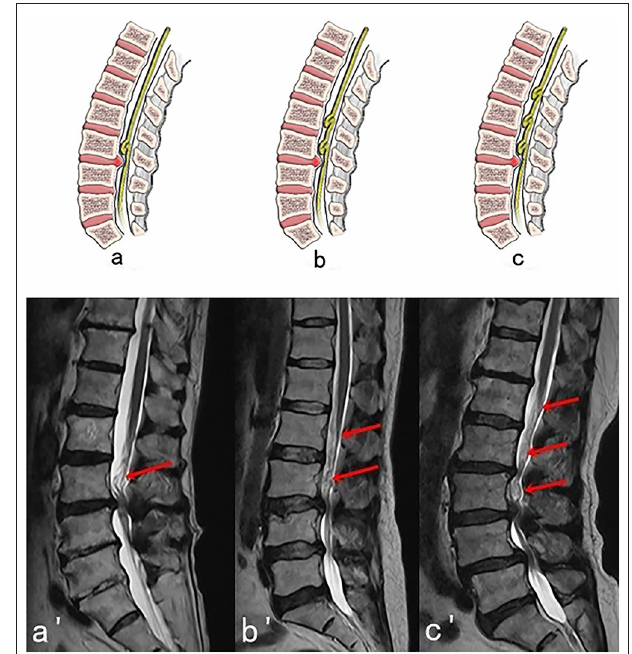
FIGURE 1 | Three possible different location of RNRs with corresponding MRI images. (A,A ′ ) Upper: redundant nerve roots (red arrow) above the level of maximal stenosis. (B,B ′ ) Lower: redundant nerve roots (red arrow) below the level of maximal stenosis. (C,C ′ ) Intermediate: redundant nerve roots (red arrows) between two levels with severe stenosis.